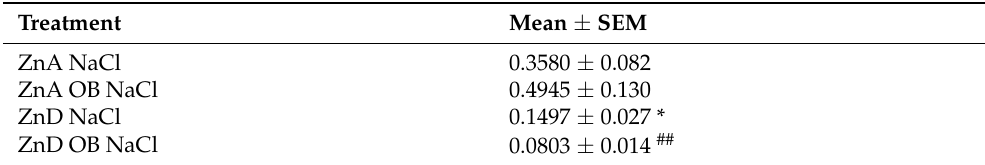
Table 1. The effects of OB, ZnD, and OB + ZnD models on serum zinc levels measured by flame atomic absorption spectrometry.